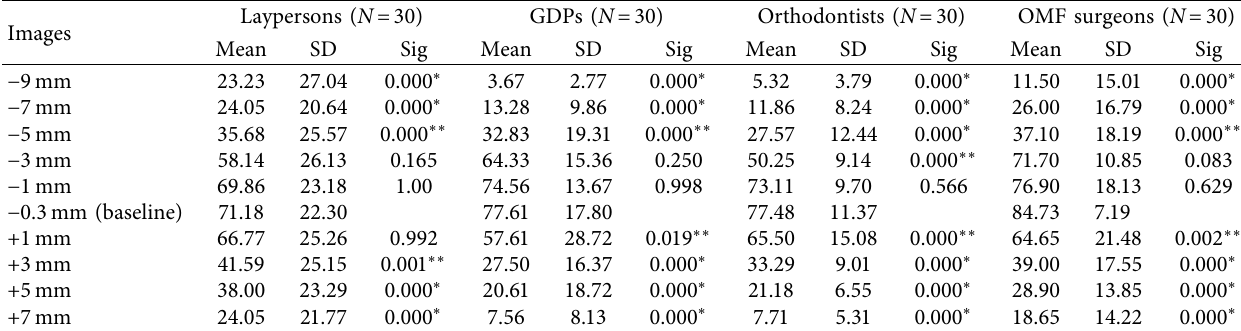
Table 1: Means and SDs of the esthetic values for the baseline profile image and the manipulated maxillary retrusion and protrusion images as perceived by the four raters’ groups. Laypersons ( N � 30) Images − 7 mm